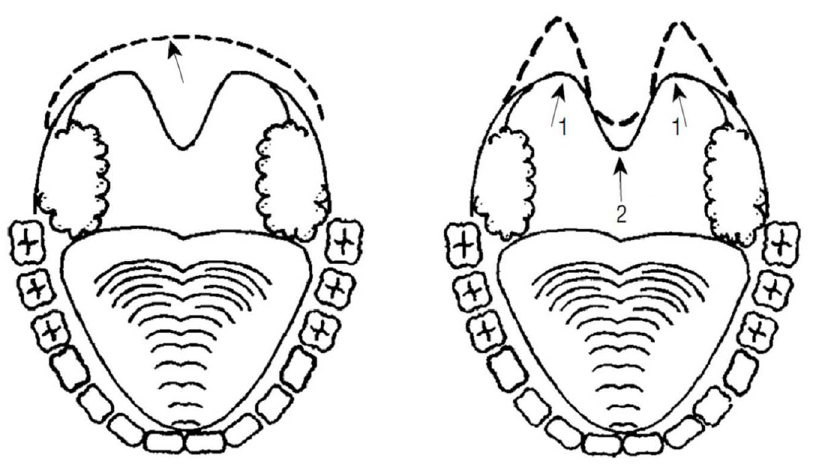
Figure 1. Schematic representation of laser-assisted uvulopalatoplasty (LAUP). The left-hand diagram shows complete resection of the uvula, the right-hand diagram shows preservation of the uvula by means of para-uvular incisions